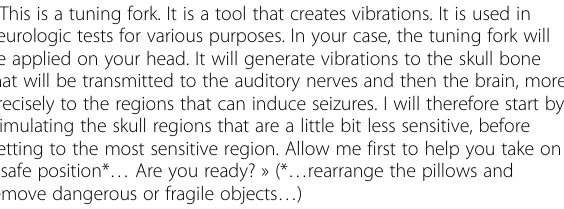
Table 2 Example of transcription of the suggestion before a tuning fork PNES induction